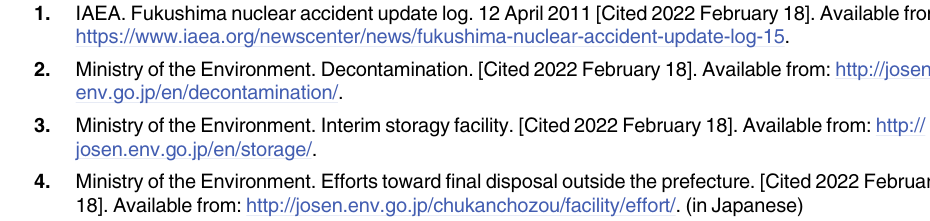
S1 Table. All responses for removed soil and incinerated ash. S1 Fig. Information about what the respondent watched before answering. Duration for which control was required, storage method, and air dose in the vicinity when volume reduc- tion was applied to the removed soil and incinerated